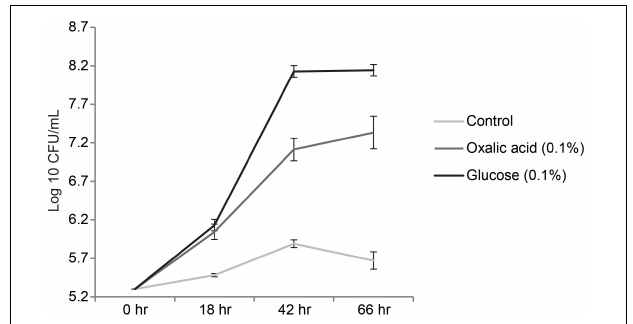
FIGURE 5 | Growth curve of P. terrae BS001 grown on M9 medium supplemented with oxalate; represents the growth patterns of P. terrae BS001 on M9 medium supplemented with 0.1% of glucose, 0.1% oxalate [w/v] and no carbon source. The Y -axis represents CFU/mL on a log 10 scale, while the X -axis shows the times in hours. Data are representative of three biological